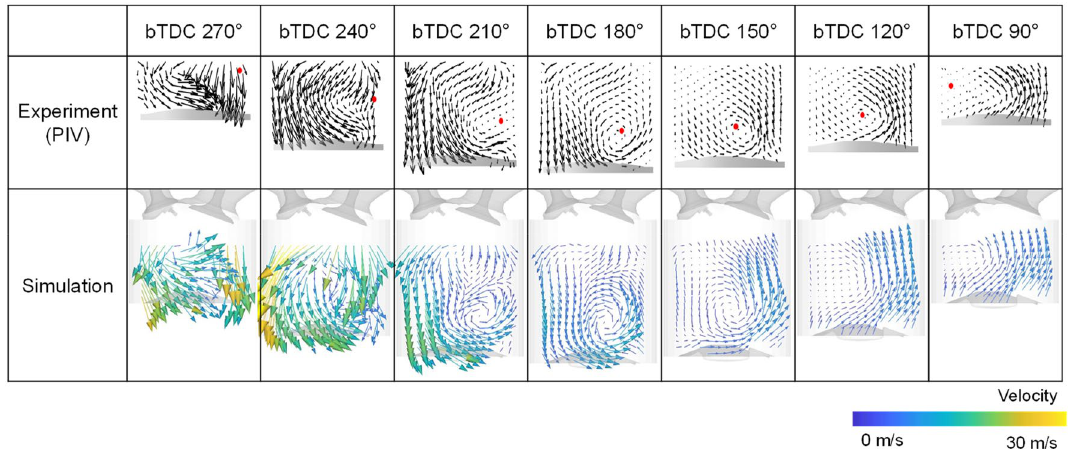
Figure 8. Comparison of the cross-sectional velocity distribution between the experiment and simulation.